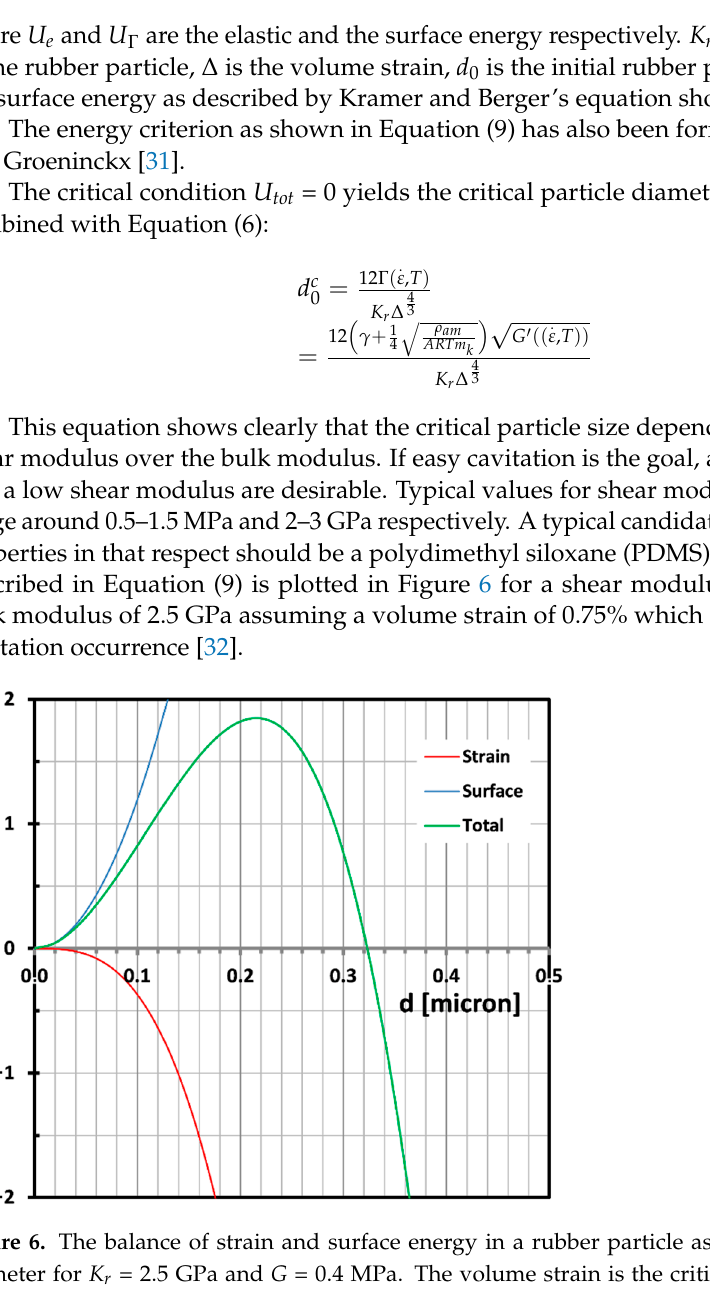
Figure 7. Transmission electron microscopy (TEM) image of the typical particle morphology in the present series of reactor copolymers. Cross-hatched lamellae are visible in the matrix phase. The dark areas are EPR rubber. The light grey blobs inside the particles are LLDPE like polyethylene (PE) and the whiter parts inside the particle are matrix occlusions. (Courtesy of Peter Neuteboom (Sabic Geleen)). Such a morphology with large differences in local modulus will lead to strain locali- zation in the EPR domains. Because of the low surface energy, these EPR areas will cavi- tate preferentially as has been shown by means of Scanning Transmission Electron Mi- croscopy computer tomography [33]. In these images it is also easily seen that the PE and the PP domains do not feature cavitation which is also to be expected in view of the tenfold higher surface energy of these areas. It is assumed that the stored elastic energy that drives the cavitation in these particles will be identical to the energy stored in a homogenous particle.